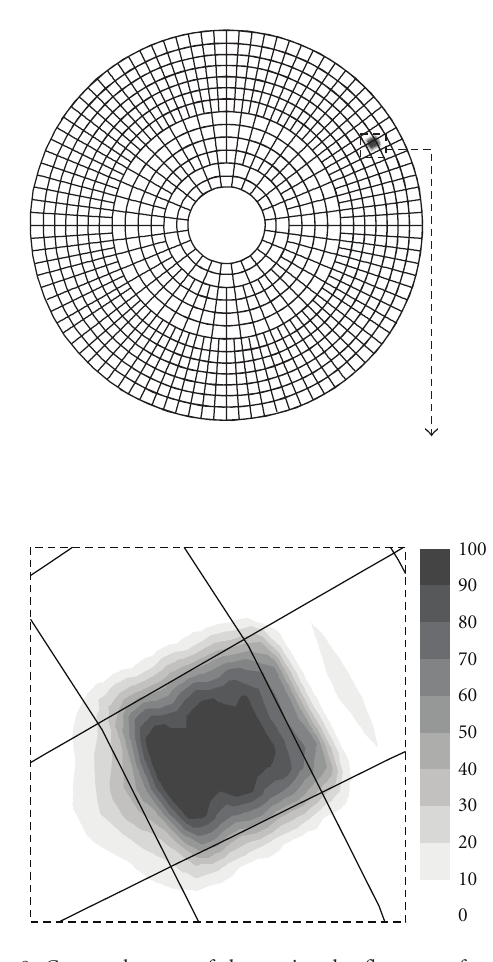
Figure 8: Gray scale map of the retrieved reflector surface for a deformation of 100 μ m of the panel under test. The gray scale bar is in unit of μ m.